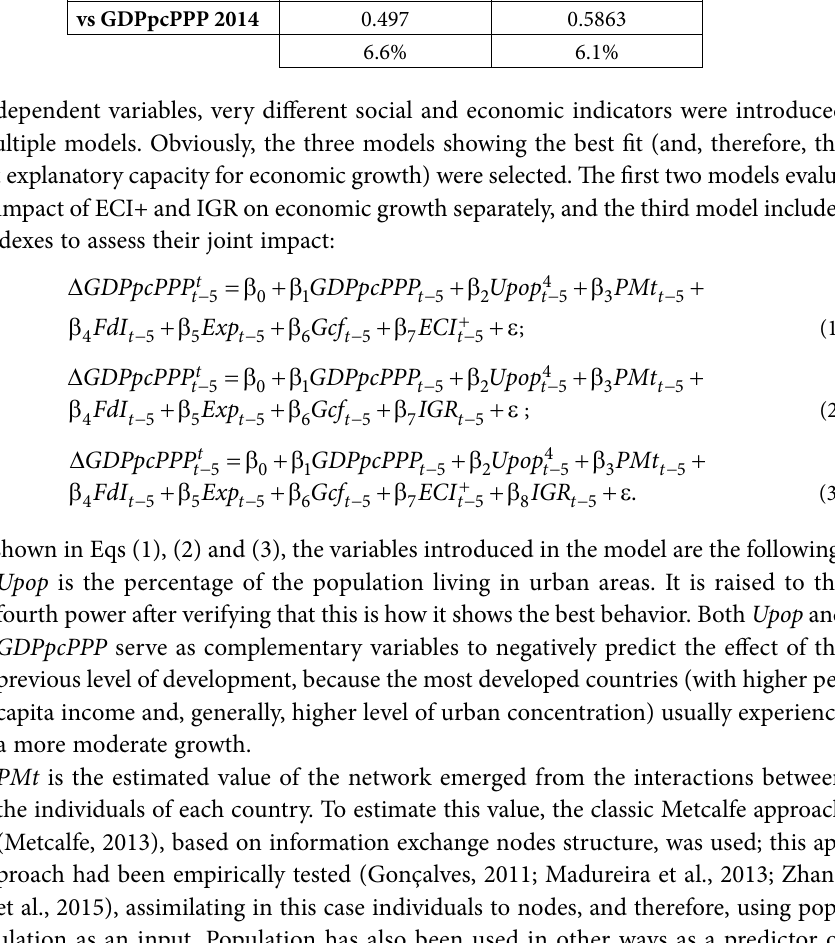
Table 2. ECI+ and IGR vs GDPpcPPP – R 2 improvement (2014–2019) ECI+ 2014 vs GDPpcPPP